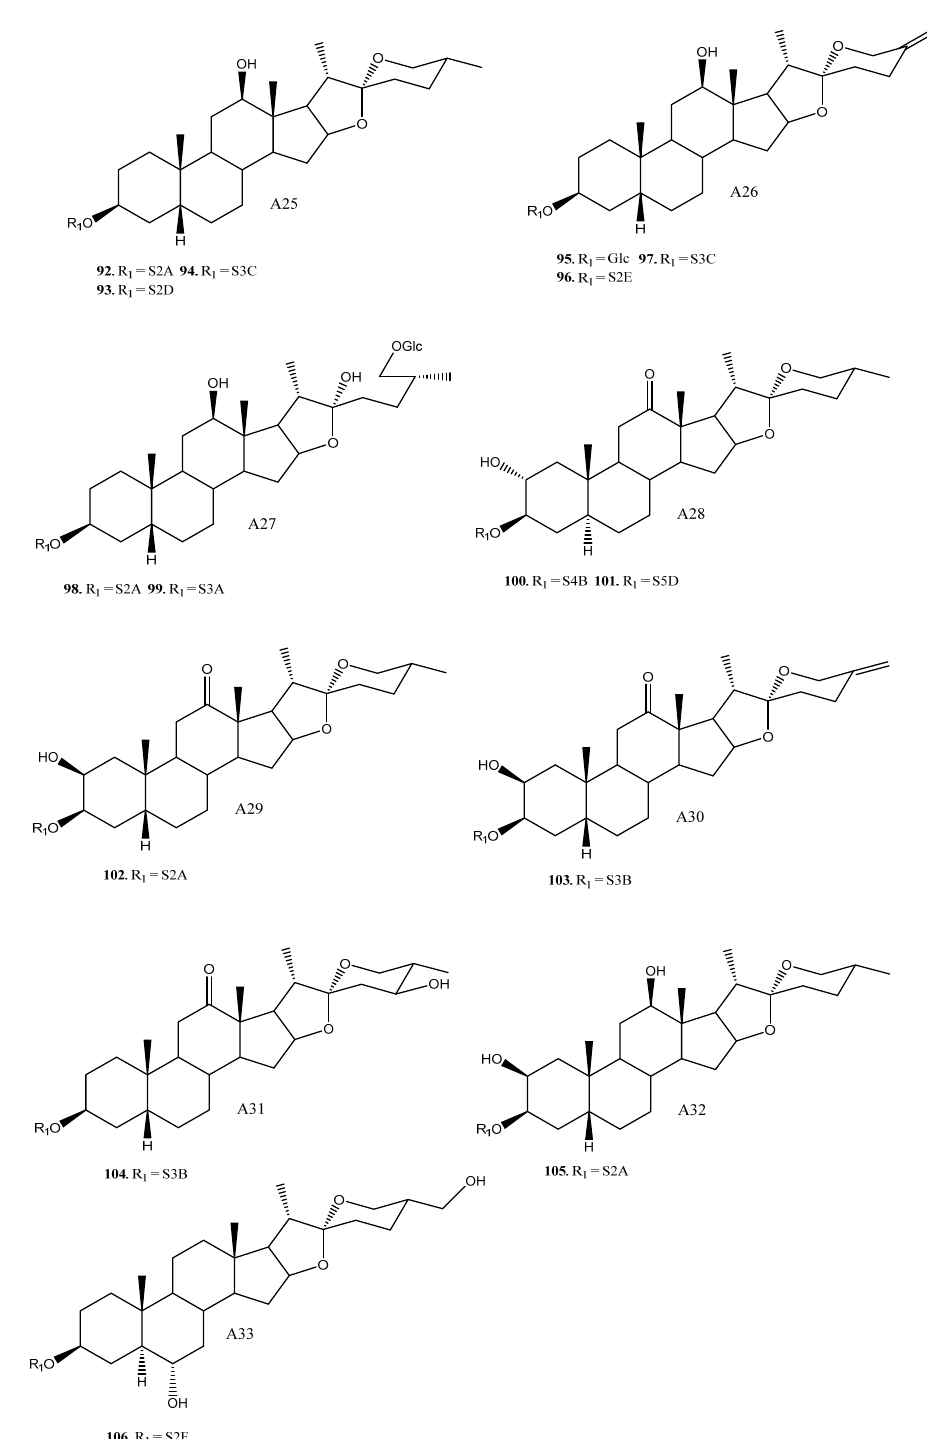
Figure 2. Structure of the spirostanic and furostanic saponins described in Yucca ( 1 – 106 ). The codes used for the aglycones ( A1 – A33 ) and the sugar chains (S#A-S#H) are included. Structures of sugars chains can be found further on Figures 6–8.